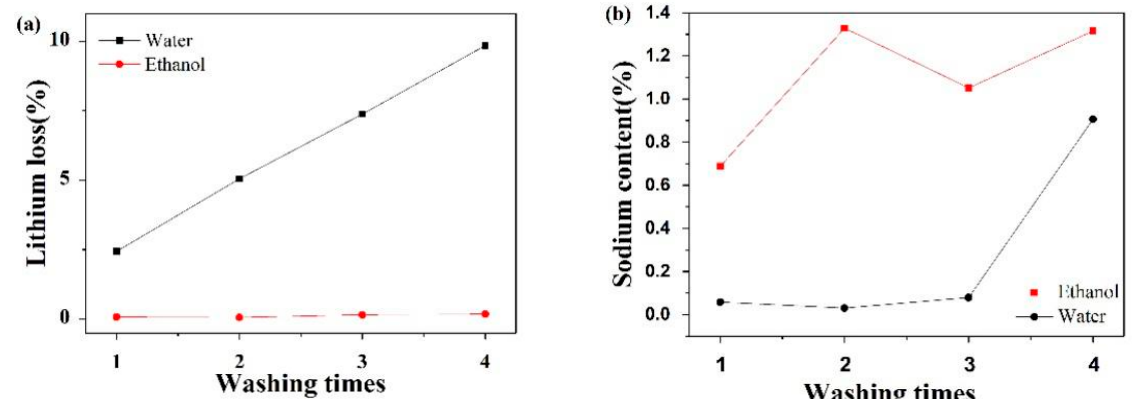
Figure 2. Washing process of water and ethanol: ( a ) lithium loss; ( b ) sodium content.